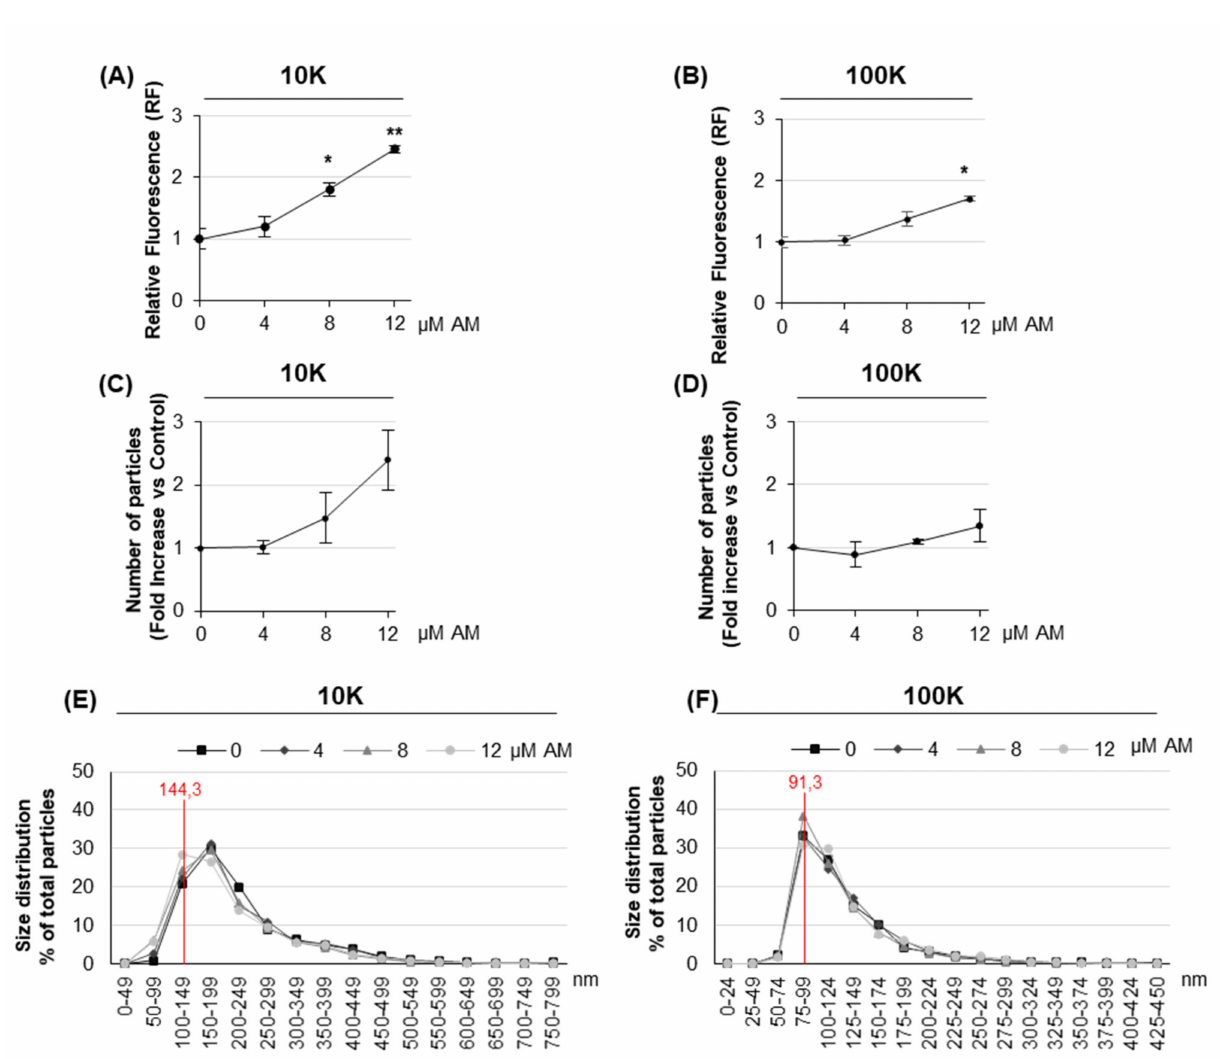
Figure 4. Analysis of EVs released by HEK-mCherry-CD63 upon AM treatment . ( A , B ) Fluorescence analysis of EVs. EVs were obtained from cell culture media by dUC at 10,000 g (10K fraction) and 100,000 g (100K fraction). Pellets were resuspended in 100 µ L PBS and assayed for fluorescence at 580 nm ex/620 nm em. Values are the mean ± S.E. of at least three experiments, each one in duplicate. * p < 0.05, ** p < 0.01 with respect to vehicle-treated cells as control (set 1). ( C , D ) Quantification of EVs. The amount of EVs in 10K and 100K fractions was measured by NTA. EV pellets were resuspended in 0.02 µ m filtered PBS to obtain a concentration within the recommended range (2 × 10 8 –1 × 10 9 particles per ml) and then loaded into a NS500 instrument. Data were calculated as number of particles/cell and reported as fold increase with respect to vehicle-treated cells as control (set 1). Values are the mean ± S.E. of at least three experiments, * p < 0.05, with respect to vehicle-treated cells. ( E , F ) Particle size distribution of 10K and 100K EVs, reported as percentage particle, i.e., the percentage of particles of the indicated diameter with respect to the total number of analyzed particles. Values are the mean of at least three experiments. The red line indicates the mode value of 10K and 100K